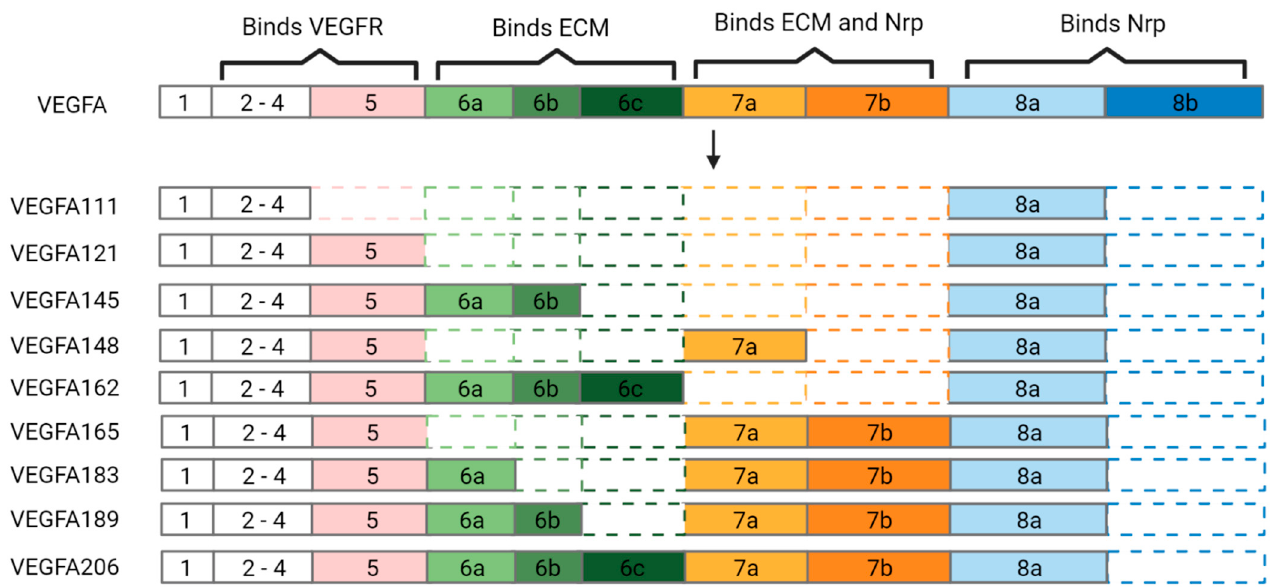
Figure 2. Comparison of VEGFA to its isoforms. The eight exons of vascular endothelial growth factor A (VEGFA) have been arranged to highlight occurrences of alternative splicing in each isoform. VEGFR: vascular endothelial growth factor receptor. ECM: extracellular matrix. Nrp: neuropilin. Image created with BioRender.com. Table 2. Comparison of biological e ff ects of VEGFA isoforms to known functions of VEGFA. Vascular endothelial growth factor A (VEGFA) and its isoforms’ e ff ects on cells, as well as their binding capacities to VEGFR1, VEGFR2, and the ECM. VEGFR: Vascular Endothelial Growth Factor Receptor. ECM: Extracellular Matrix.